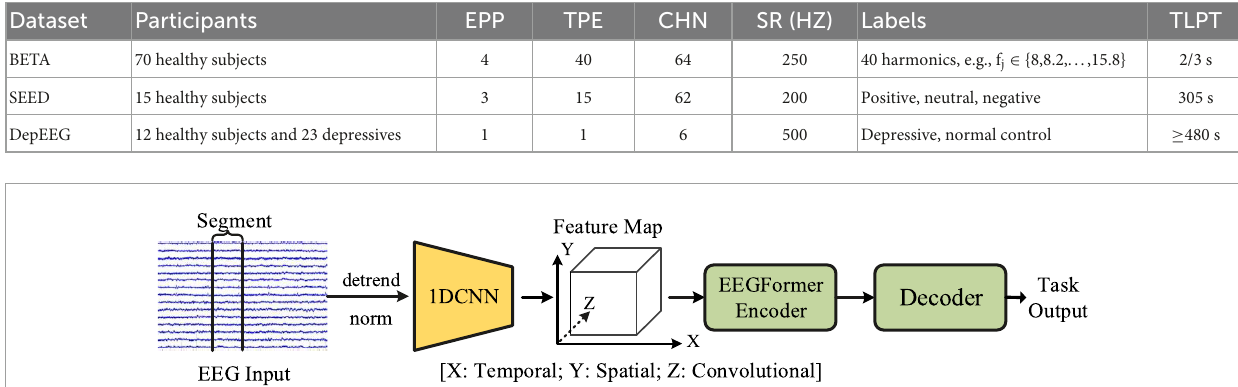
FIGURE1 Pipeline of EEGformer for different tasks of brain activity analysis.